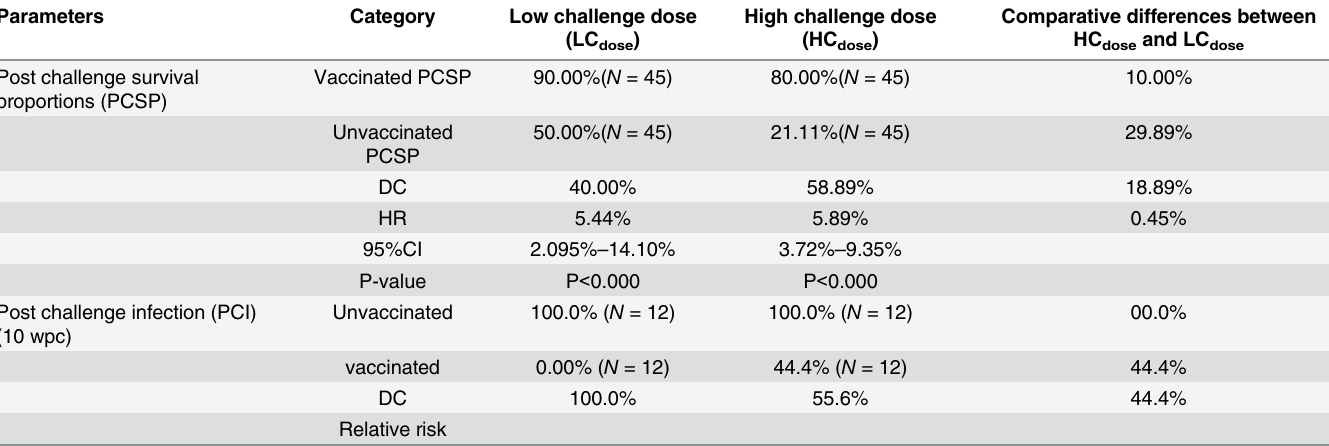
Table 2. Comparison of post challenge survival proportions and infections of the high and low challenge dose of strain